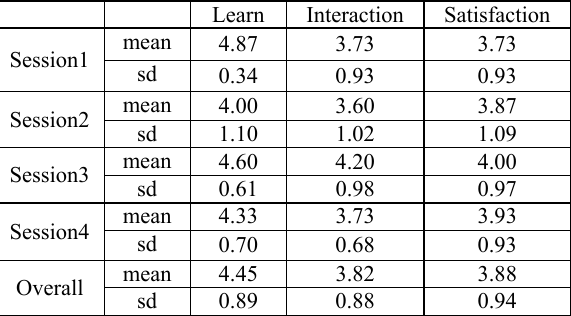
Table 2. User rating for the system. Session 1-4 refer to damaged area selection, region splitting, region merging and interactive